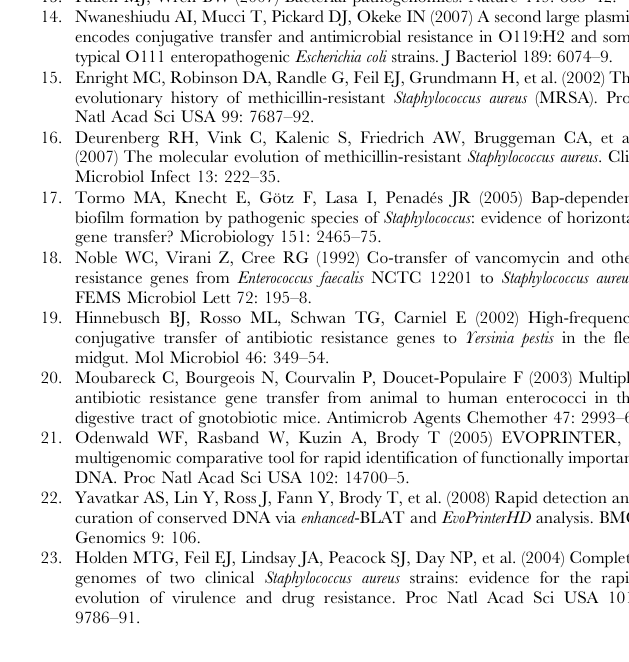
Figure S2 Identification of HGT exchanges between plasmid and bacterial genomes. EvoPrinter comparative analysis of the Staphylococcus pTZ2162 plasmid with the S. aureus COL; S. aureus MRSA252; S. aureus MSSA476, S. aureus Mu50; S. aureus MW2; S. aureus N315; S. aureus NCTC 8325; S. aureus RF122; S. aureus USA300; S. aureus JH1; S. aureus JH9; S. aureus Mu3 and S. aureus Newman genomes identifies HGT sequences that are uniquely shared with different bacterial genomes. Shown is a pTZ2162 plasmid DNA EvoDifferences profile (25,815 to 30,799 bp) that highlights two different putative HGT events. Highlighted with green-colored letters, pTZ2162 uniquely shares a 766 bp sequence with the human MRSA252 genome that includes a partial match to the blaZ gene (ORF boxed). Flanking the MRSA252 - pTZ2162 shared homology is a 2,121 bp fragment (red-colored sequences) that is uniquely shared with the bovine RF122 chromosome that contains the quinone oxidoreductase / DT diaphorase gene (ORF